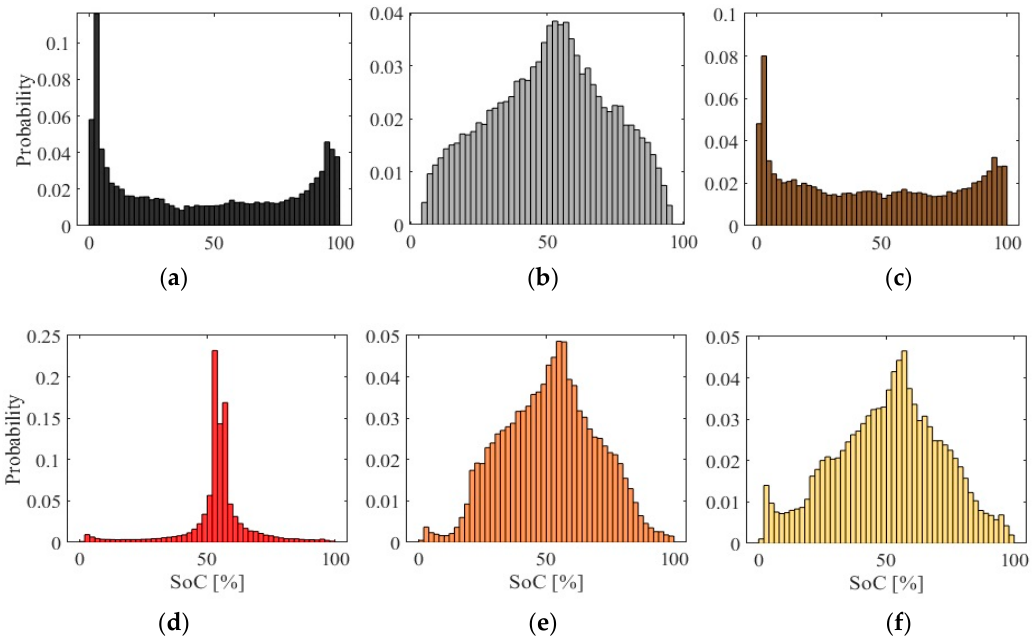
Figure 10. SoC distribution during the yearly simulation for the active SoC restoration strategies studied: ( a ) Base case; ( b ) No DoF case; ( c ) O/U case; ( d ) DB case; ( e ) AE case; ( f ) DT case. Y-axis represents the fraction of time in the year in which SoC is at a particular level.